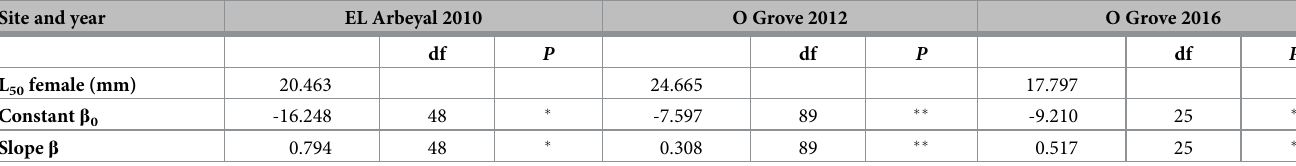
Table 6. Parameters of the logistic female maturity function and estimated female L 50 .